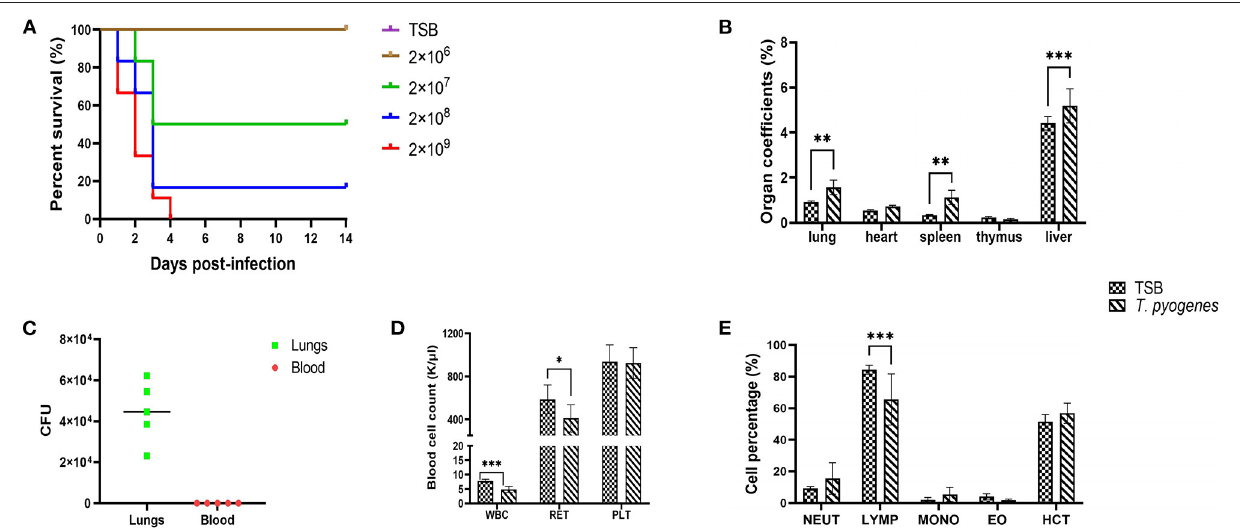
FIGURE 3 | Virulence of T. pyogenes strain 20121 in a mouse model. Mice were challenged intraperitoneally with the strain 20121, as described in the Experimental Procedure. (A) Survival percentage of mice inoculated with strain 20121 or tryptic soy broth (TSB; control). (B) Organ coefficients after 20121 infection at 2 dpi. (C) Bacterial loads in lung (CFU/g of tissue) and blood (CFU/ml). (D) White blood cell (WBC), reticulocyte (RET) and platelet (PLT) count after T. pyogenes infection. (E) Percentage of neutrophilic granulocyte (NEUT), lymphatic number (LYMP), monocyte (MONO), eosinophil (EO), hematocrit (HCT) after T. pyogenes infection. Results are expressed as means ± S.D., and significance was determined using two-way ANOVA and the Sidak multiple-comparison test. * p < 0.05; ** p < 0.01; *** p <